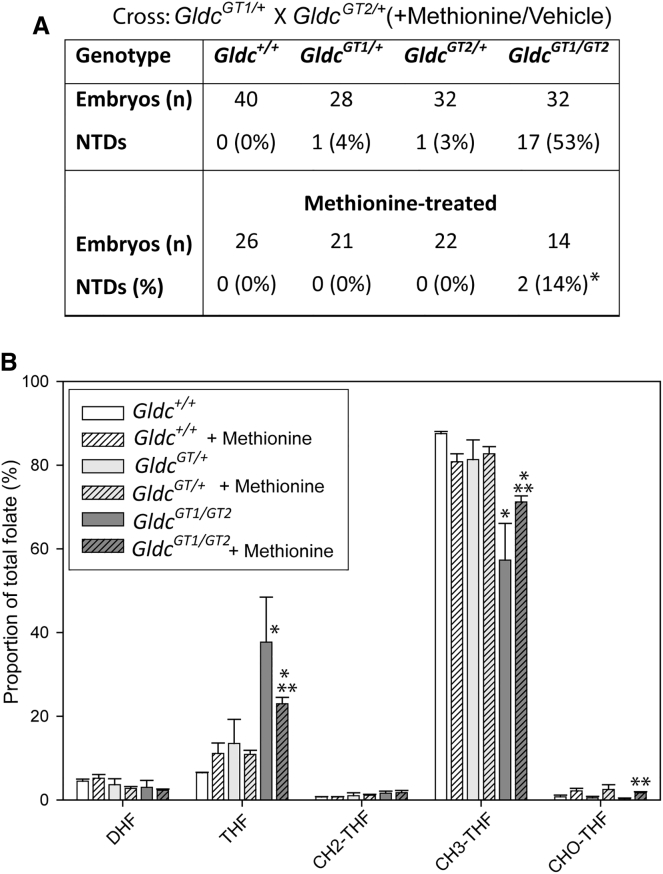
Methionine Supplementation of Gldc-Deficient Embryos Is Associated with Normalization of the Folate Profile and Prevention of NTDs(A) Compared with controls (n = 20 litters), maternal supplementation with methionine from E7.5 (n = 12 litters) resulted in a lower frequency of NTDs among homozygous mutant embryos (significant difference from controls; ∗p < 0.05, Fisher’s exact test).(B) Folate profile of embryos collected at E10.5 following maternal methionine treatment (n = 3–6 embryos per group). Significant differences in relative abundance between genotypes and/or treatment were noted for THF, 5-methyl THF, and formyl THF (p < 0.001, two-way ANOVA; ∗, significant difference from other genotypes within treatment group; ∗∗, significant effect of methionine treatment within the same genotype).